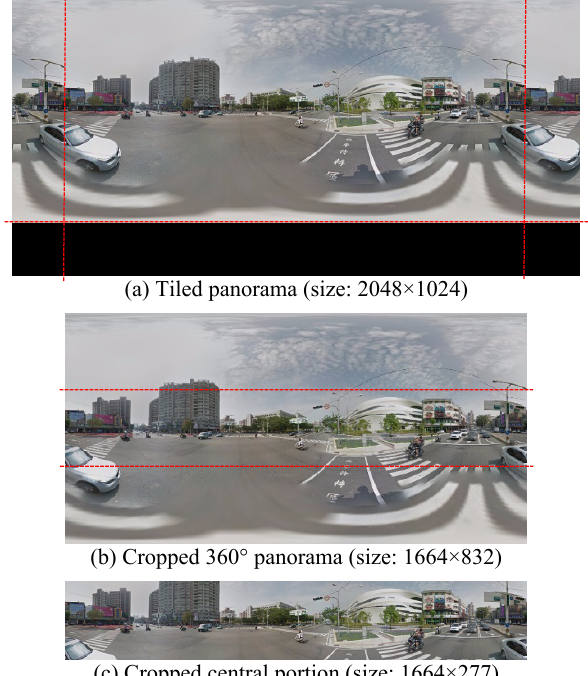
Figure 1. GSV 360° panorama cropping (zoom